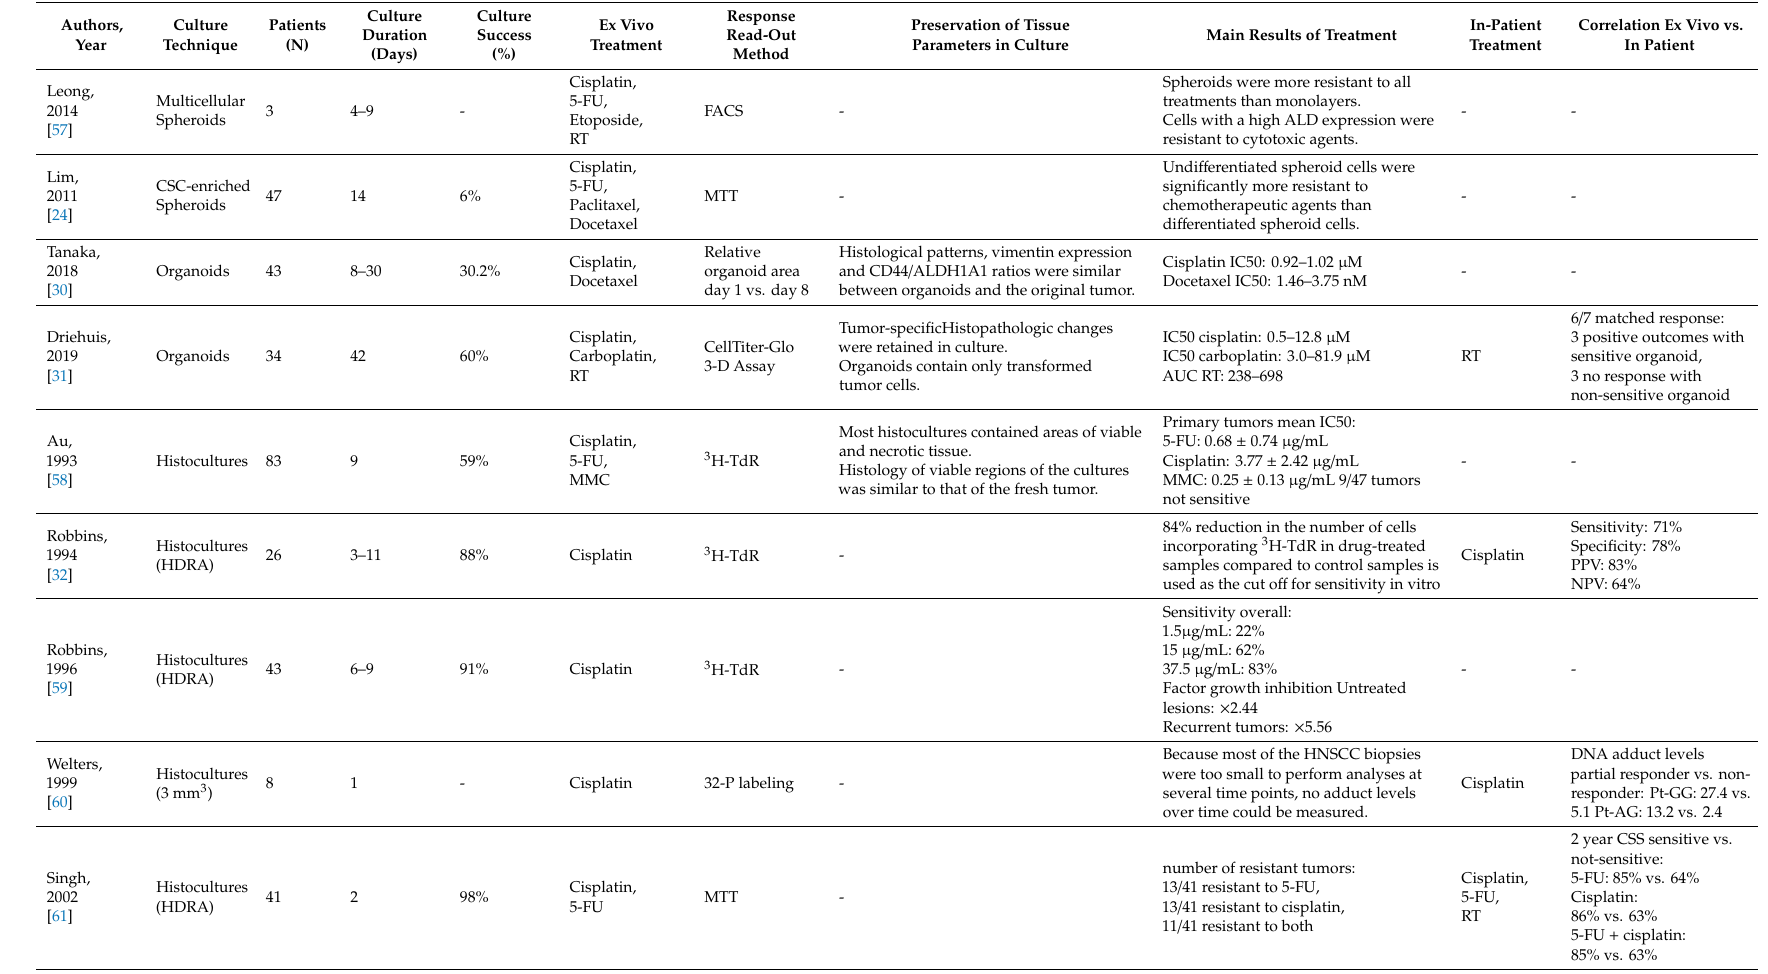
Table 3. Overview of selected studies using chemotherapy or radiotherapy on various cultures from HNSCC tissue.